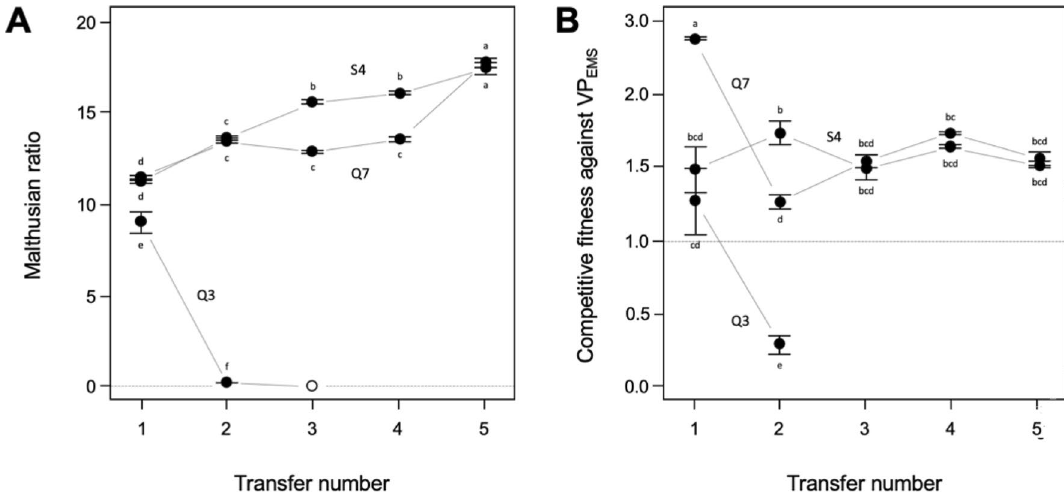
Figure 6. ( A ) Static—Malthusian ratio (no VP EMS ) and ( B ) competitive fitness against VP EMS .